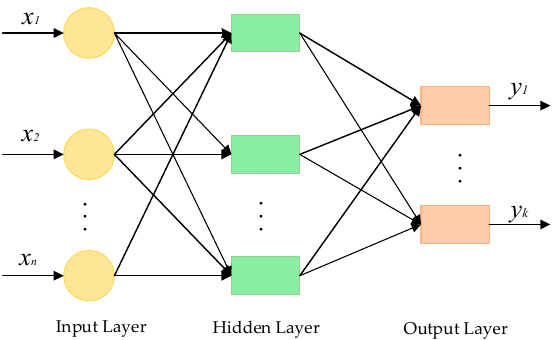
Figure 8. Schematic diagram of RBFNN structure. The typical radial basis functions (basis functions) of the RBFNN hidden layer are Gaussian function, inverse S-type function and quasi-multiquadratic function, and the expressions are shown in Equations (4)–(6) respectively. The common function of RBFNN hidden layer is Gaussian function (Equation (4)).